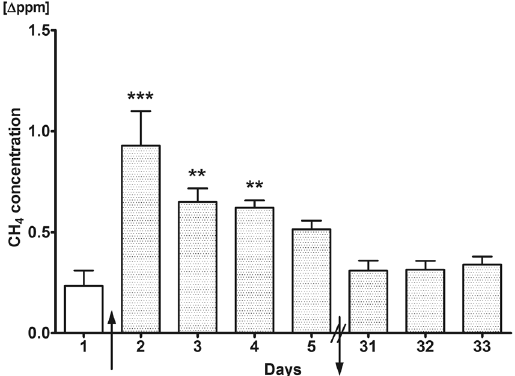
Figure 1. Exhaled CH 4 production profile of humans during the course of the study. Exhaled CH 4 production on days 1–5 and 31–33 of the investigation is depicted. During the first measurement on day 1, all volunteers were untreated. Alcohol consumption induced significant CH 4 production by the 2 nd day compared to the 1 st day, and this level decreased remarkably by the 5 th day. Mean values and standard error of mean (SEM) are given; ** p < 0.01 and *** p < 0.001 vs . day 1. The arrows pointing upwards and downwards represent start and end of alcohol intake, respectively. Statistics: one-way ANOVA with Dunnett’s multiple comparison